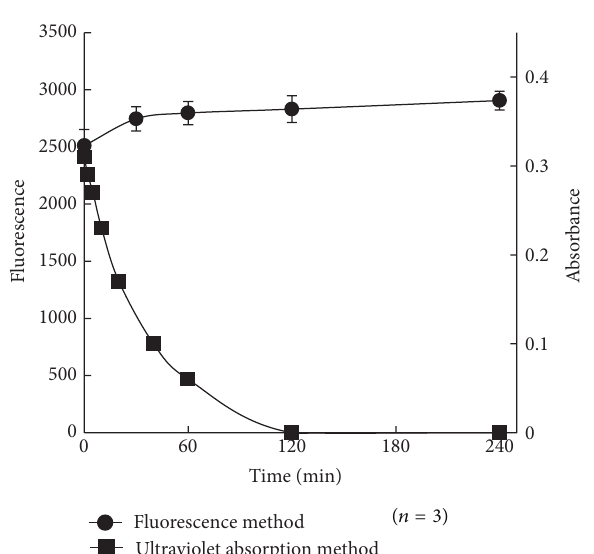
Figure 7: Standard curve for ozone.